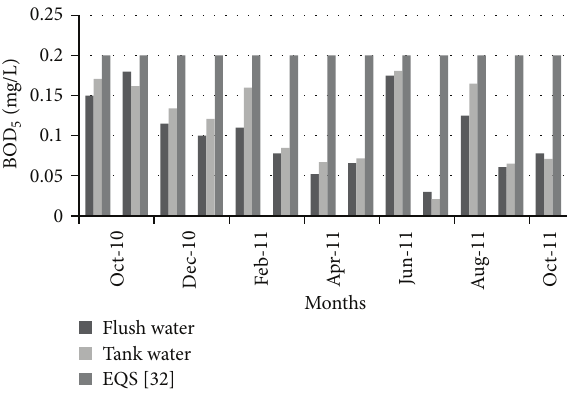
Figure 15: Variation of BOD 5 over